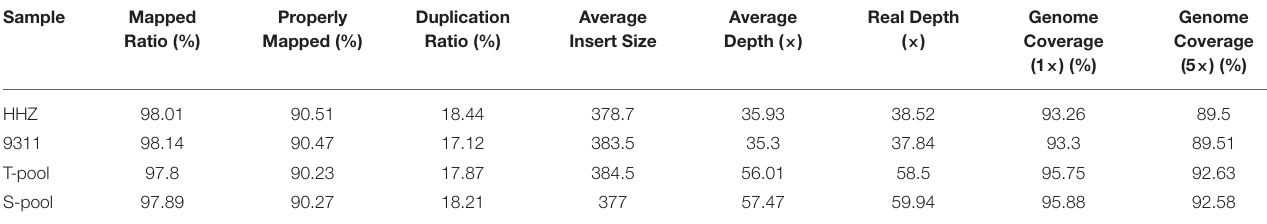
TABLE 2 | Statistical analysis of sequencing depth and coverage.